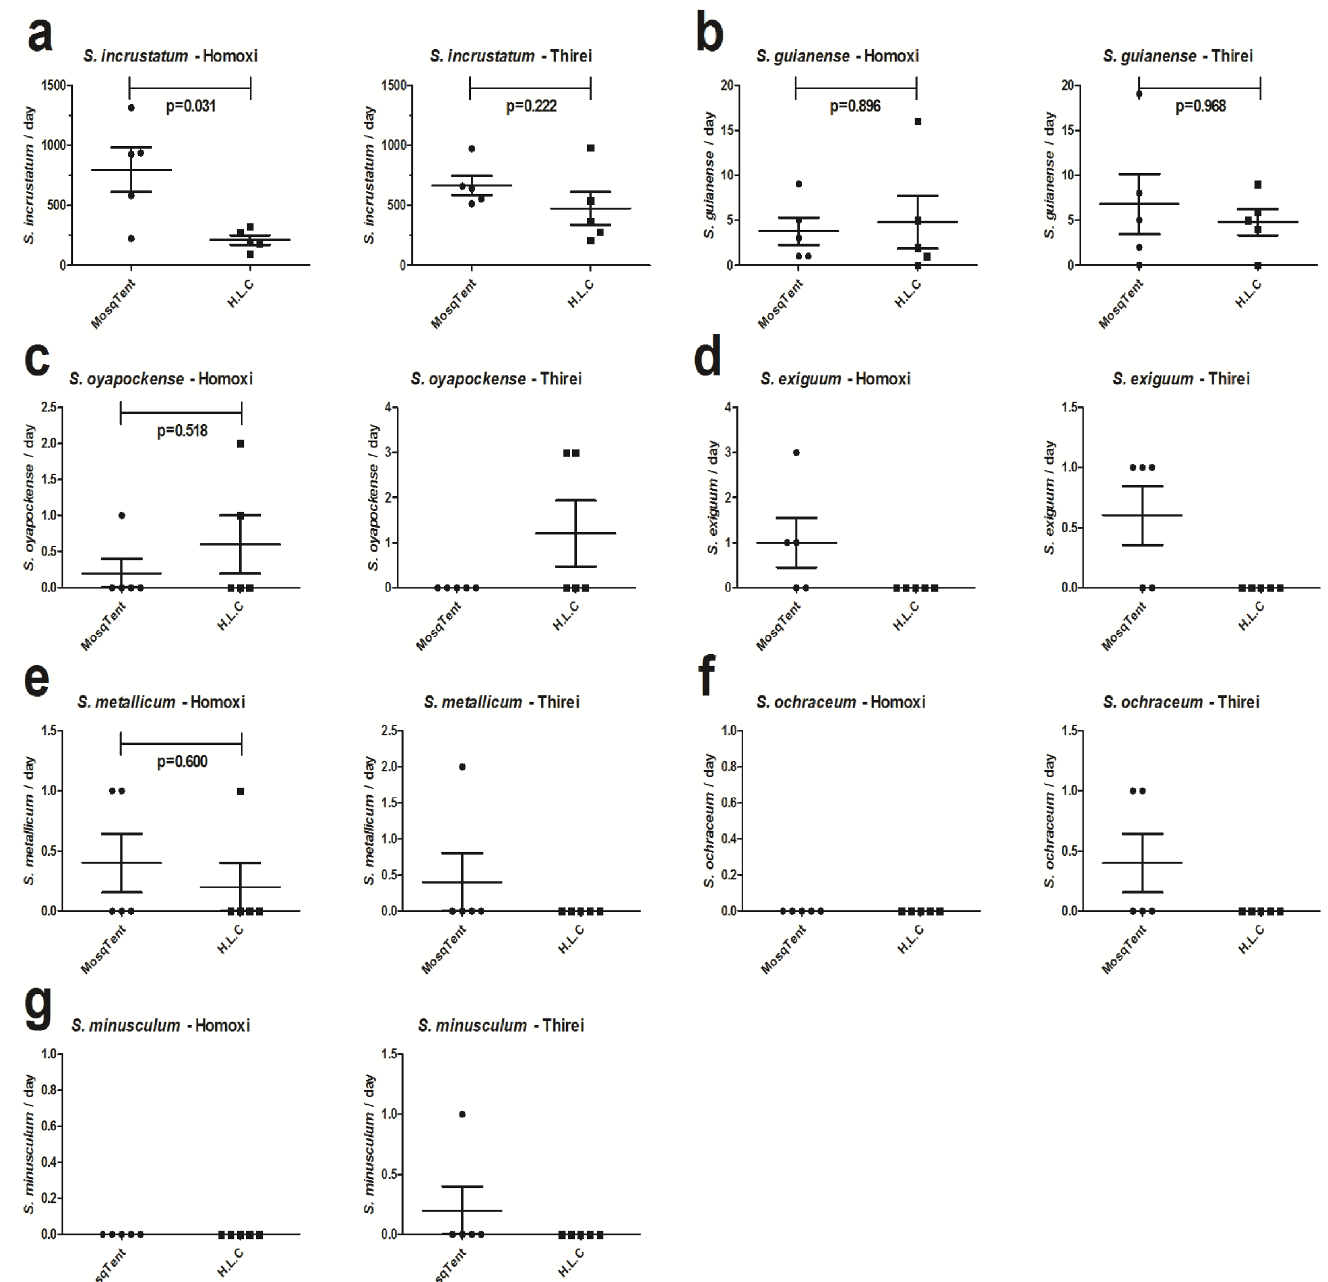
Fig 4. MosqTent ® trap performance and HLC method at Homoxi and